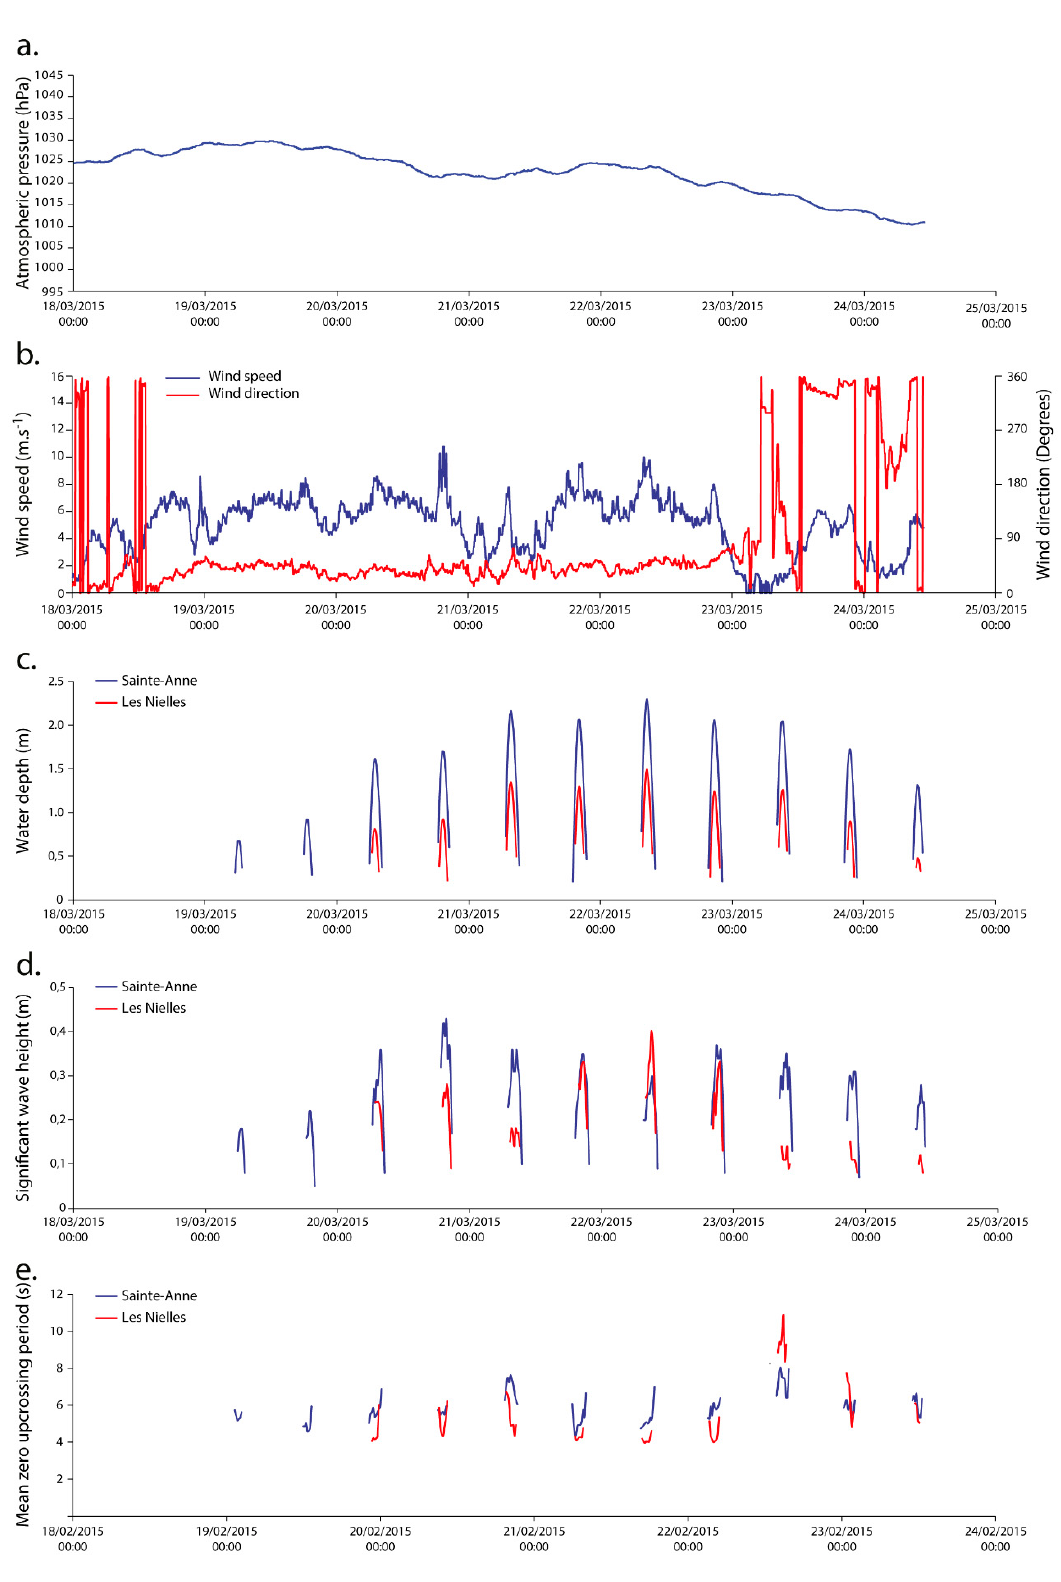
Figure 6. Synthesis of hydrodynamics data during Experiment 2, March 2015 ( a ) atmospheric pressure data, ( b ) wind data, ( c ) water depth data, ( d ) significant wave height data, ( e ) mean zero upcrossing period data.